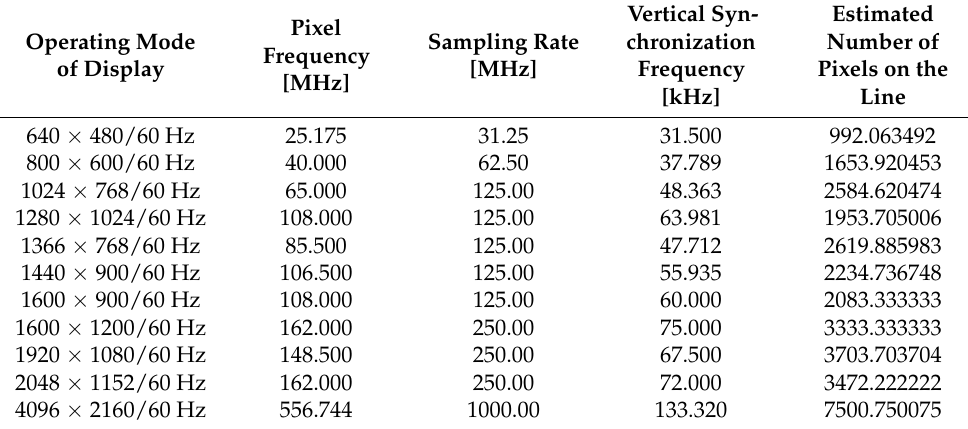
Table 2. Nominal raster parameters for sampling